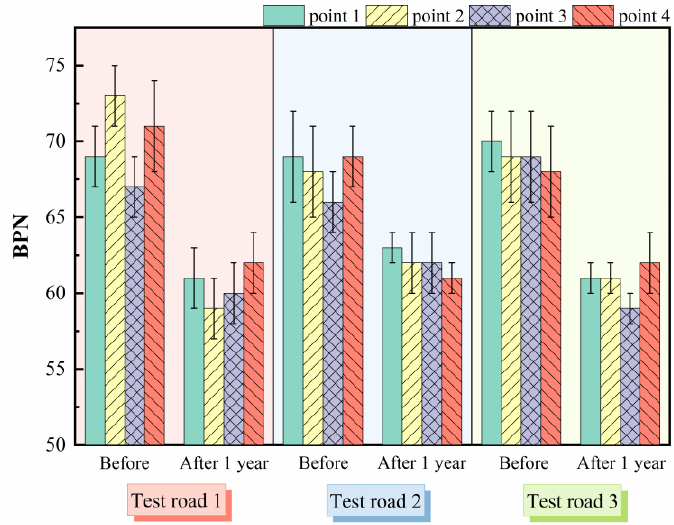
Figure 11. Pendulum test results before and after test roads